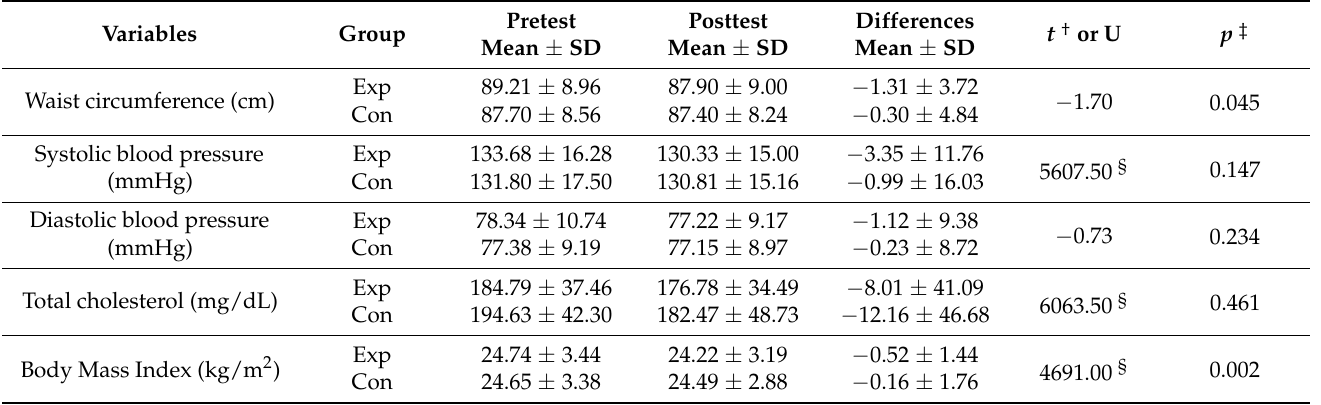
Table 2. Comparing the effects of the physical exercise program on physiological indicators. Variables Group